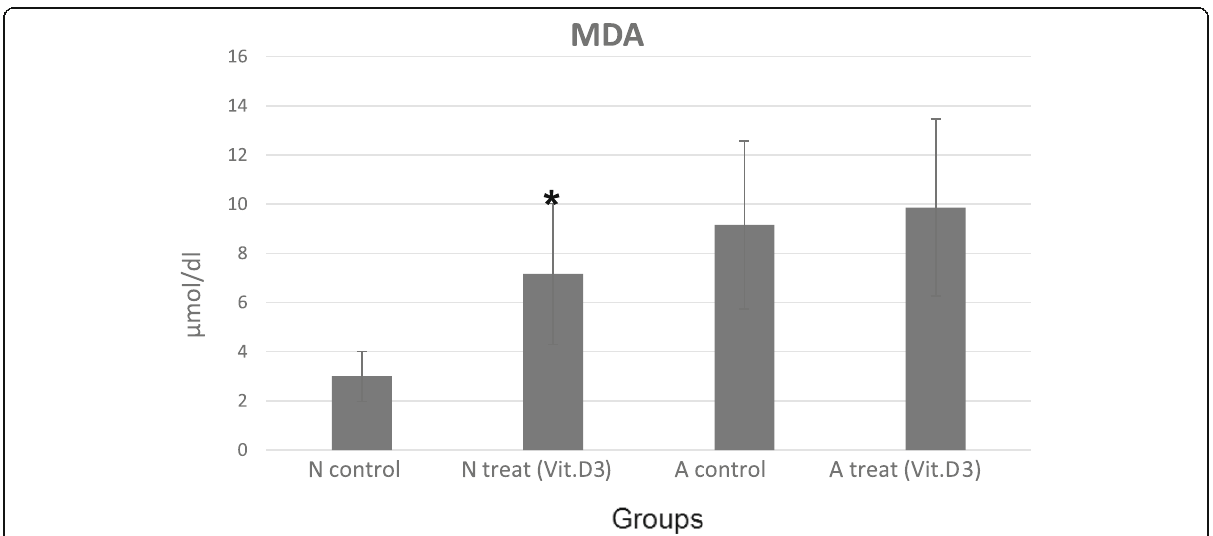
Fig. 4 Effects of Vit.D3 on MDA in normal (N) and asthenozoosperm (A) samples. The values are expressed as means of MDA concentration.